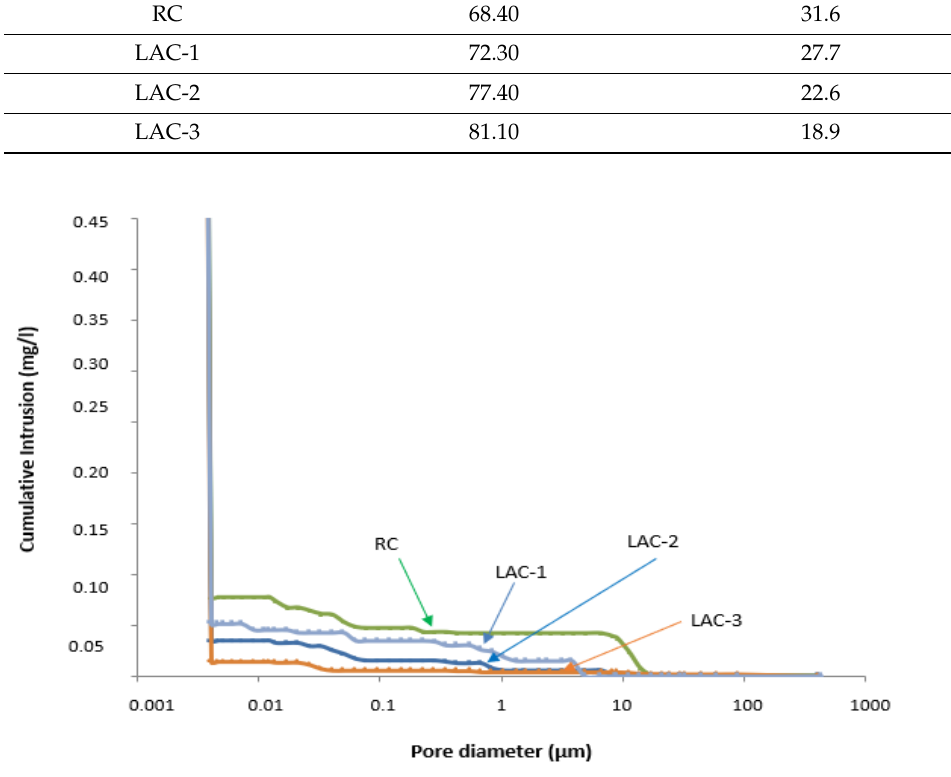
Figure 12. The pore structure analysis of the mixes. Table 4. The calculated percentage of the micro and macro pores.